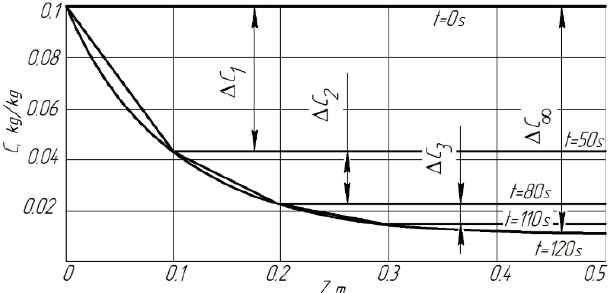
Figure 2. Dependence between the fine fraction concentration and vertical coordinate in time.